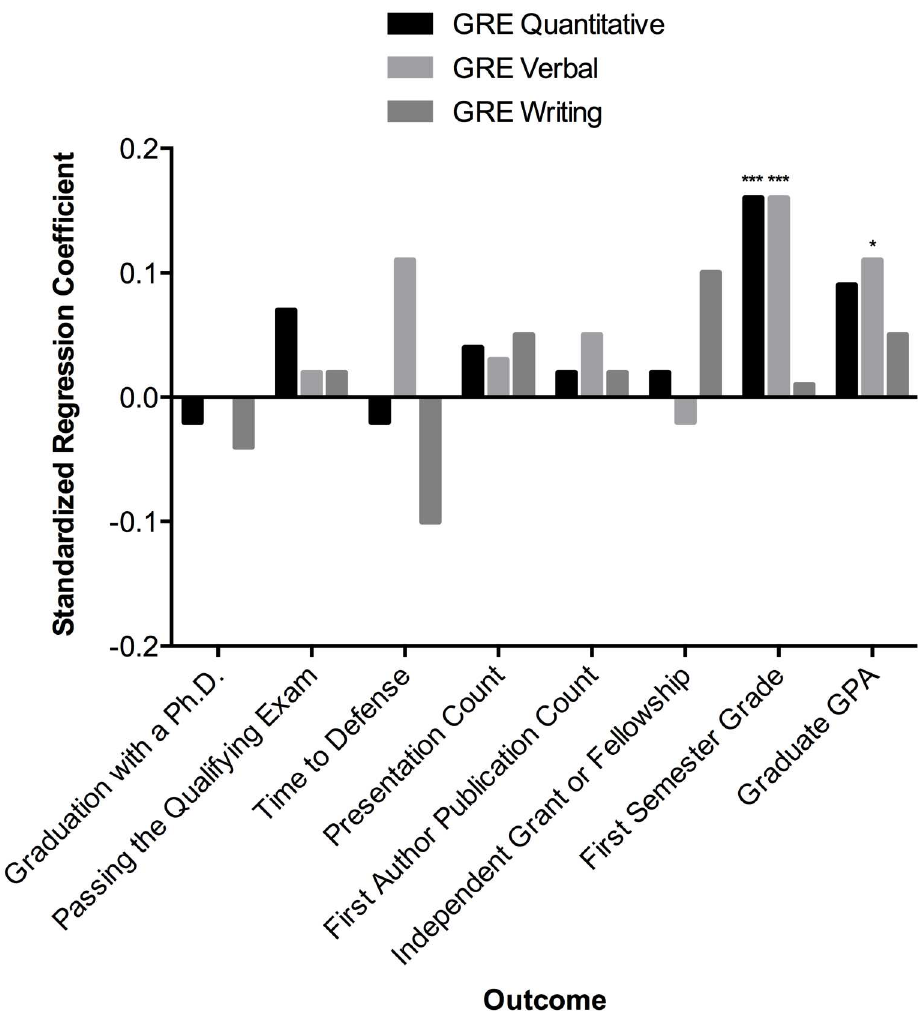
Fig 2. The predictive power of GRE scores on different measuresof student success. Standardized regression coefficients reportedafter controlling for other admissionscriteria. Cohort fixed effects are included for each model. Coefficients of zero appearas missing bars. * p < .05. ** p < .01. *** p <